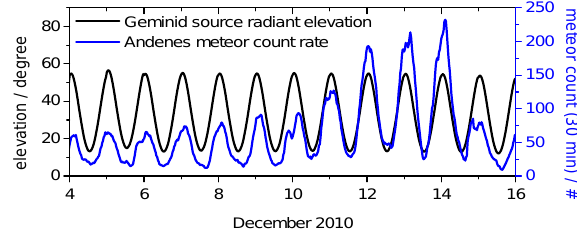
Fig. 8. Comparison of observed Geminid meteor activity with the elevation of the Geminid source radiant above the horizon. The x-tickmarks indicate 00:00UTC for each day.